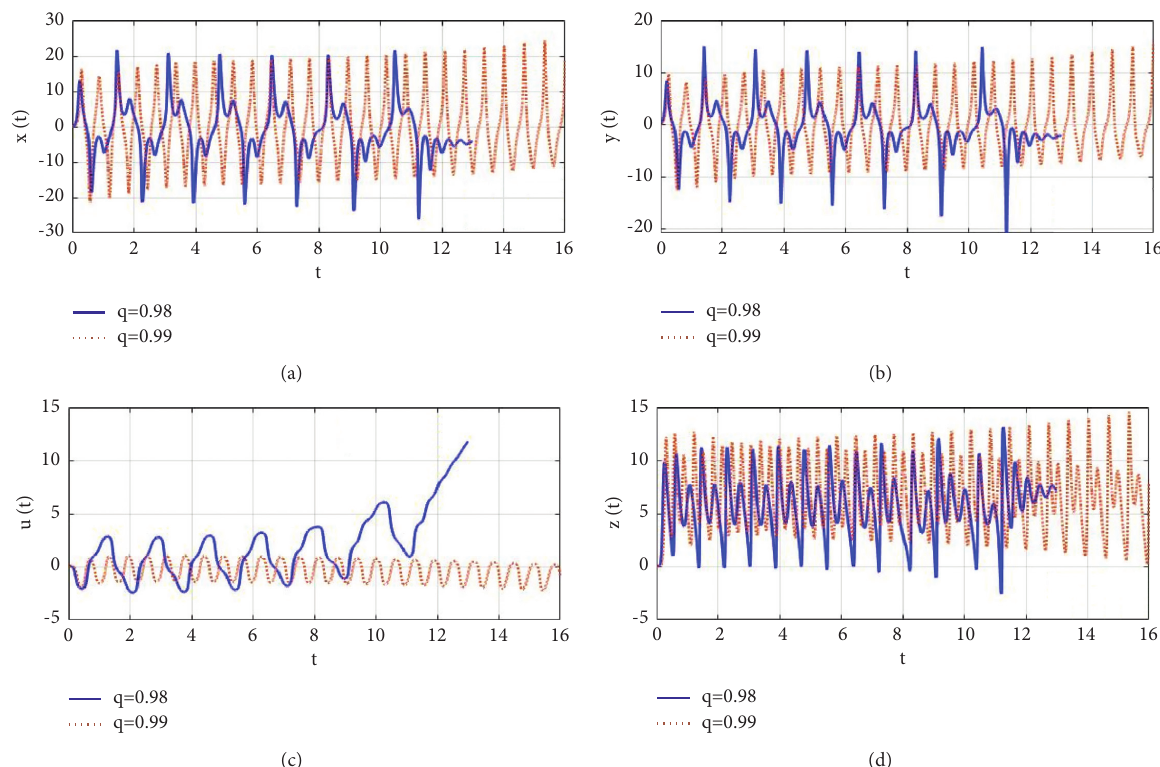
Figure 14: Some of the time series orbits of the system (25) due to different fractional-order